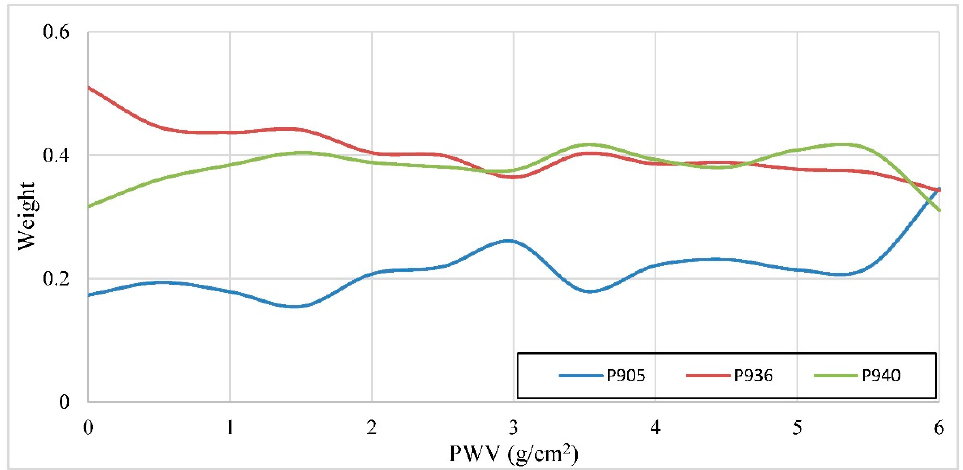
Figure 9. The weights of three original MERSI-2 PWV datasets participating in fusion calculated based on their uncertainty.